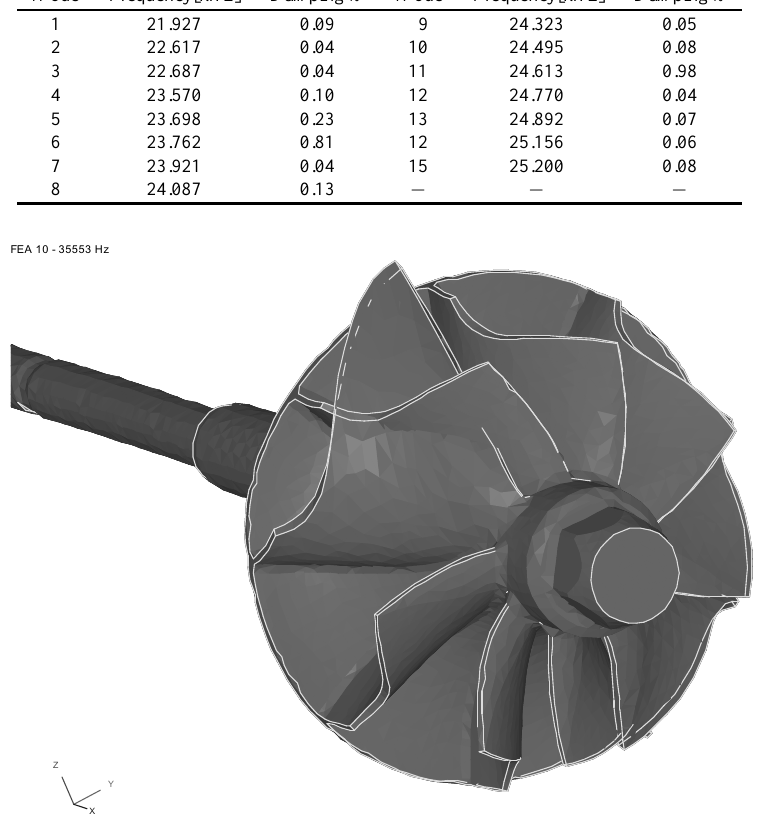
Fig. 6. A single blade mode, about 22